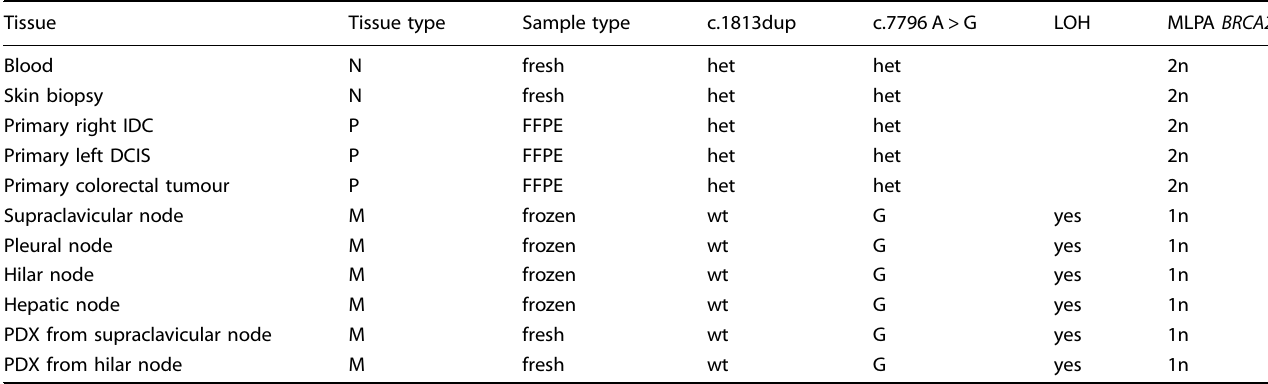
Table 1. BRCA2 biallelic genetic validation and tumor sample analysis from FA663 patient. Sanger sequencing of BRCA2 exons 10 and 16 and allelic copy number analysis by MLPA for all the samples analysed.